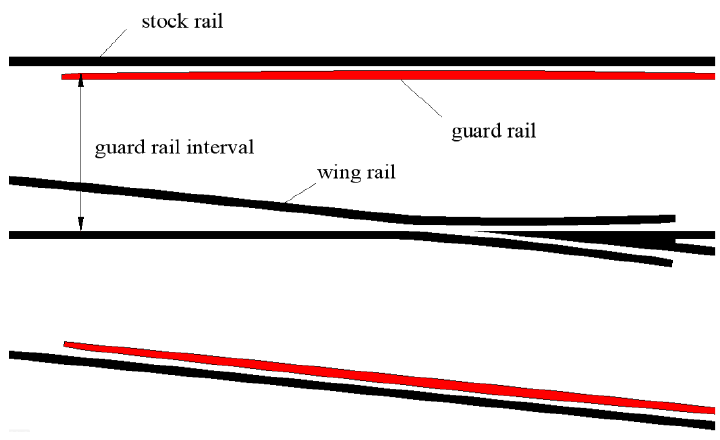
Figure 2. Guardrail interval.